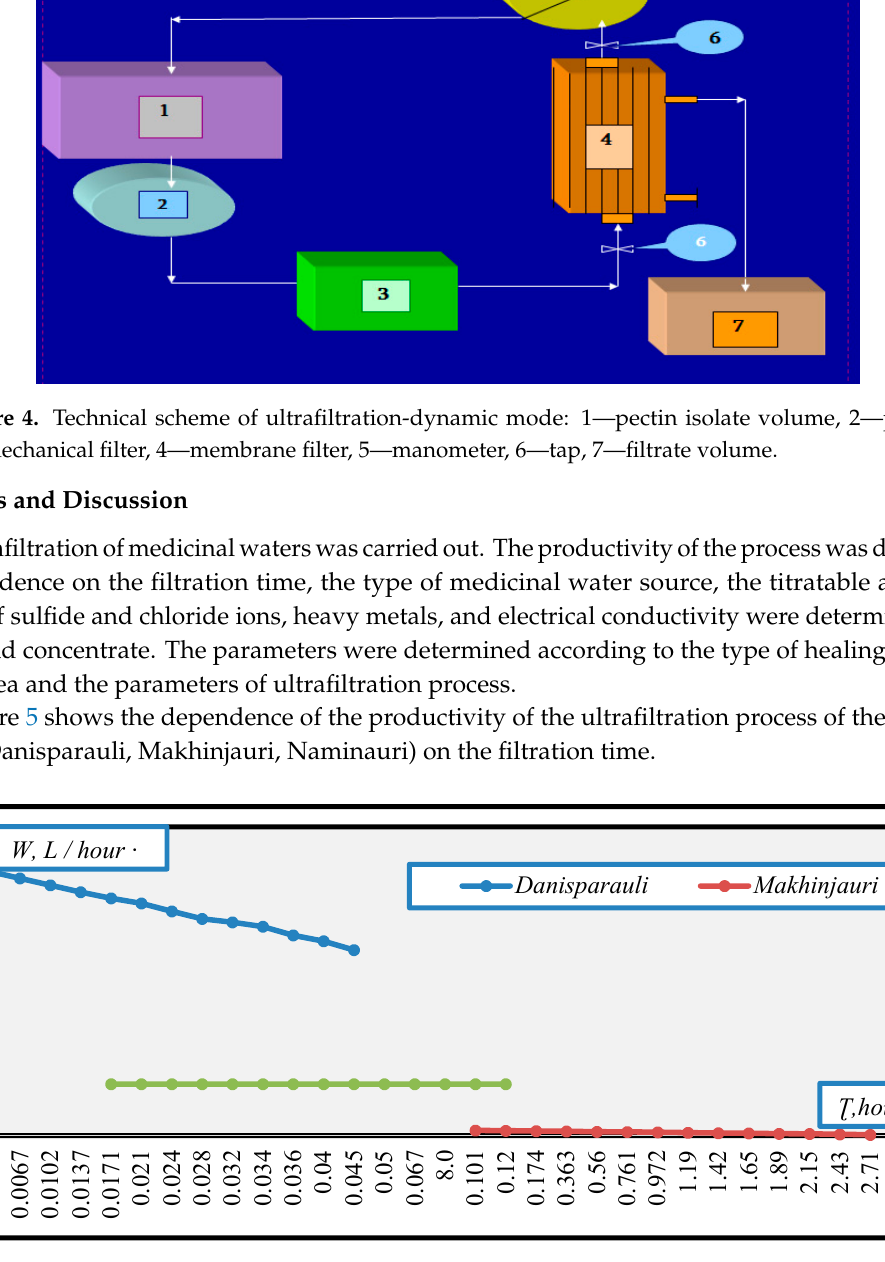
Figure 5. The dependence of the productivity of the ultrafiltration process on time.